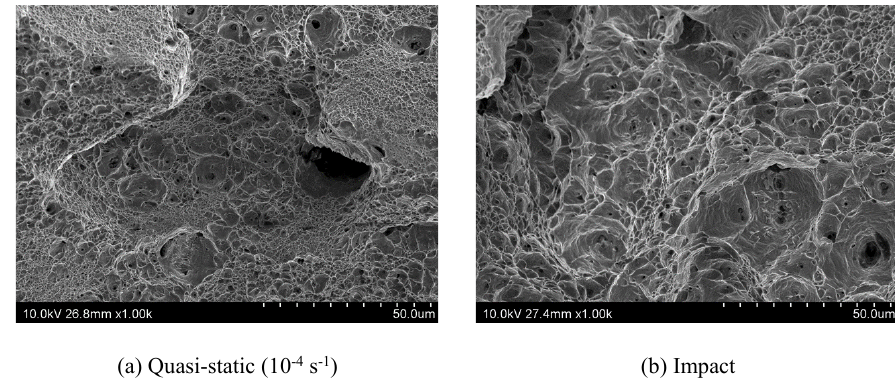
Fig. 6. SEM micrographs of the fracture surfaces at the quasi-static and impact strain